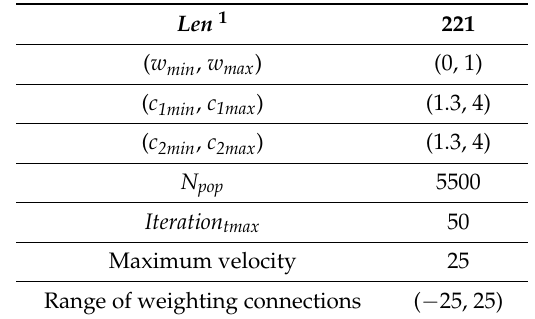
Table 2. Parameters used by the PSO for the ANN in this paper.